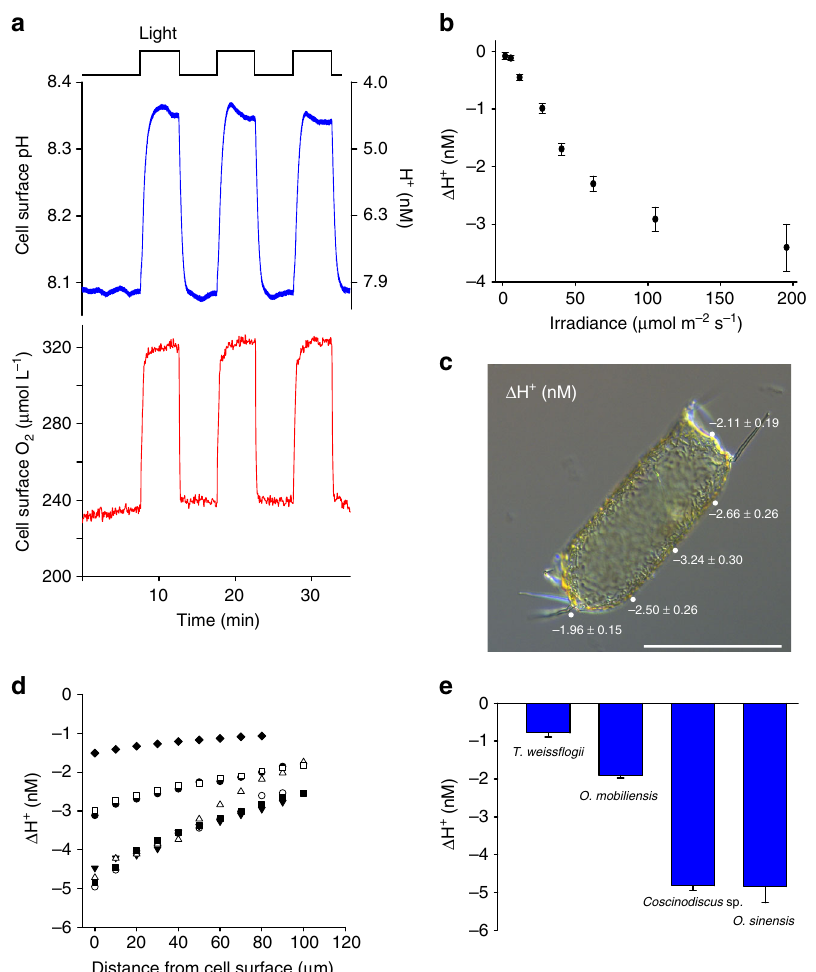
Fig. 1 Photosynthetic DIC uptake results in an increase in pH at the cell surface. a Light-dependent changes in cell surface pH (upper) and [O 2 ] (lower) around the large diatom Odontella sinensis measured using microelectrodes. Upon illumination there are very rapid increases in pH and [O 2 ]. b The increase in cell surface pH is strongly dependent on irradiance. The mean change in cell surface [H + ] ( ± s.e.m.) following illumination is shown ( n = 12 cells). c Bright fi eld microscopy image of an O. sinensis cell illustrating spatial variability in cell surface pH in the light. The mean change in [H + ] ( ± s.e.m.) following illumination was measured at different positions around the cell in seawater at pH 8.0 ( n = 12 cells). The positions of the microelectrode are shown around a representative cell. Bar = 100 µ m. d The zone of elevated pH extends signi fi cantly away from the cell. For each illuminated cell, pH was recorded at 10 µ m increments away from the cell. The change in [H + ] from the bulk seawater is shown (pH 8.0). n = 7 cells. e Comparison of the light-dependent increase in cell surface pH in four centric diatoms; Thalassiosira weiss fl ogii (approximate length 20 – 25 µ m) , Odontella mobiliensis (length 40 – 60 µ m), Coscinodiscus sp. (diameter 140 – 170 µ m) and O. sinensis (length 150 – 250 µ m). The mean light-dependent change in cell surface [H + ] in seawater at pH 8.0 is shown ( ± s.e. m.) ( n =